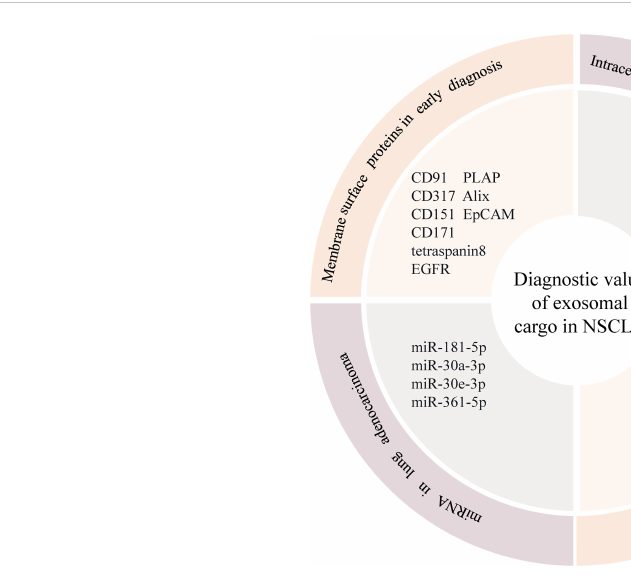
FIGURE 1 Diagnostic value of exosomal cargo in